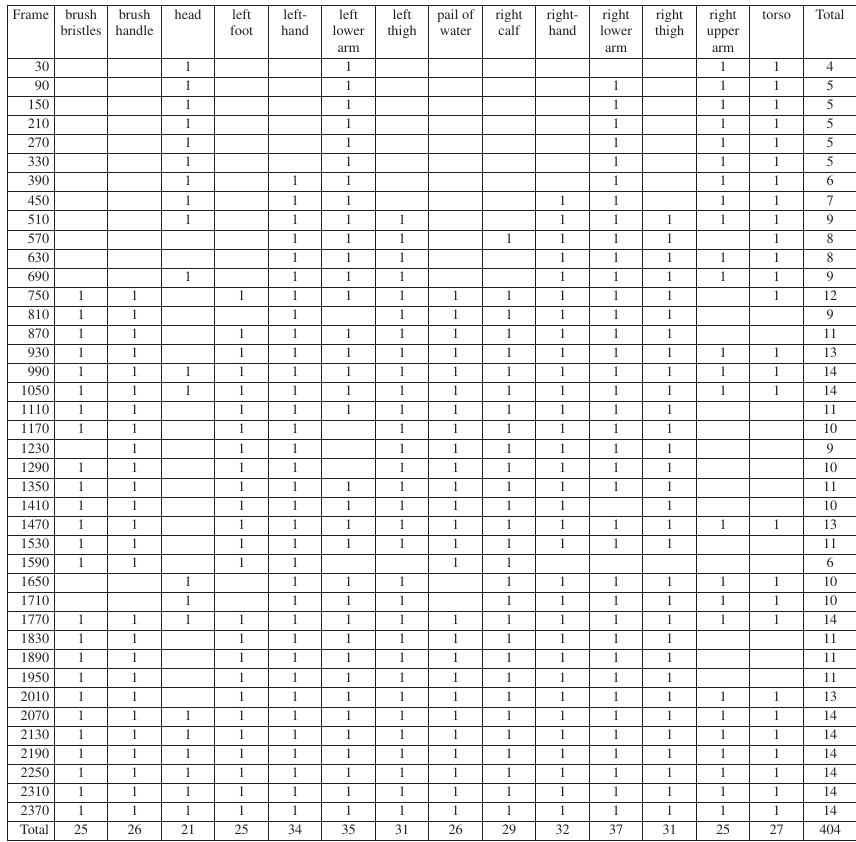
Table 2. Ground truth of the parts that are visible in each